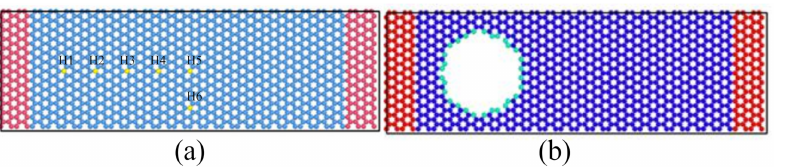
Figure 10. ( a ) Schematic diagram of the location of the circle center of the circular hole defect on graphene, ( b ) Graphene model of the circular hole defect with circle center location H3.